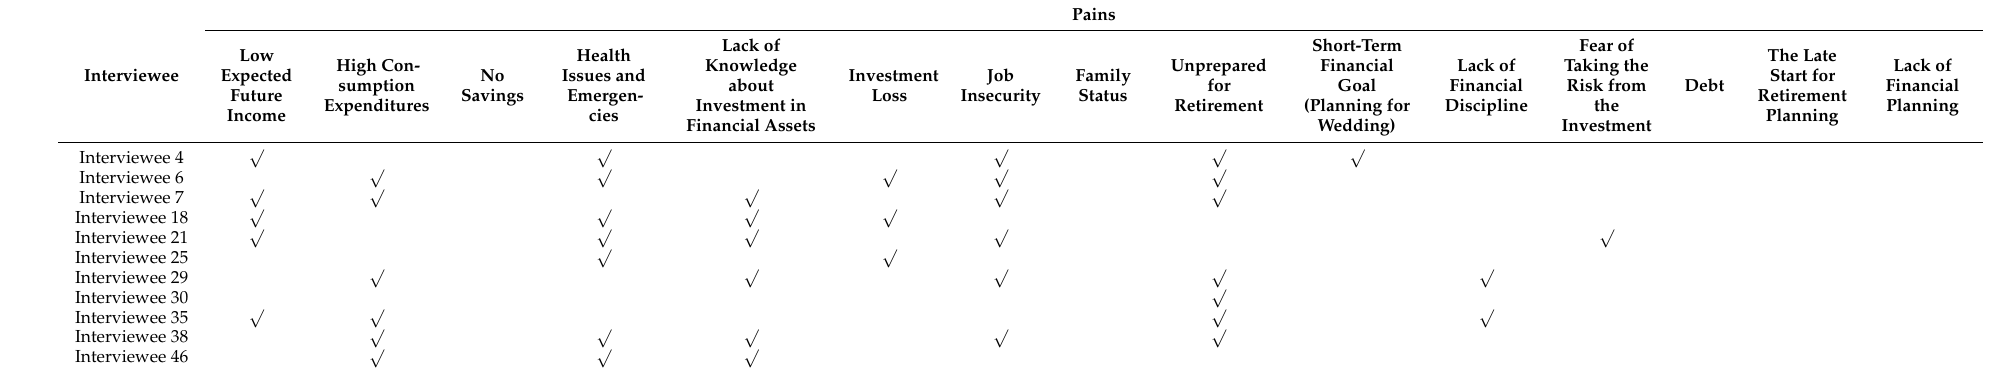
Table 4. Most common pains from interviewees of segment 1.